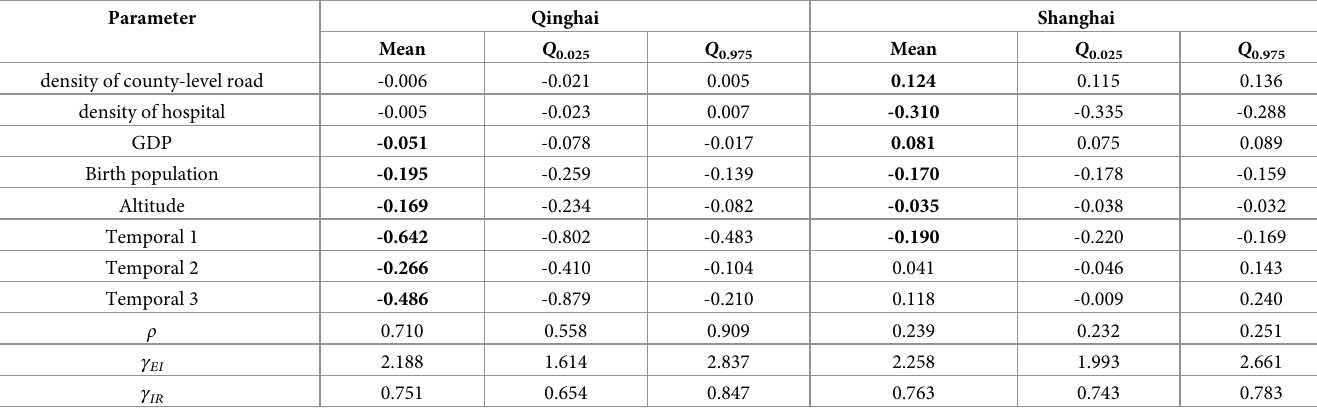
Table 2. Posterior estimates (mean and quantiles) for HFMD in Qinghai and Shanghai, 2009 to 2016. Parameter Qinghai